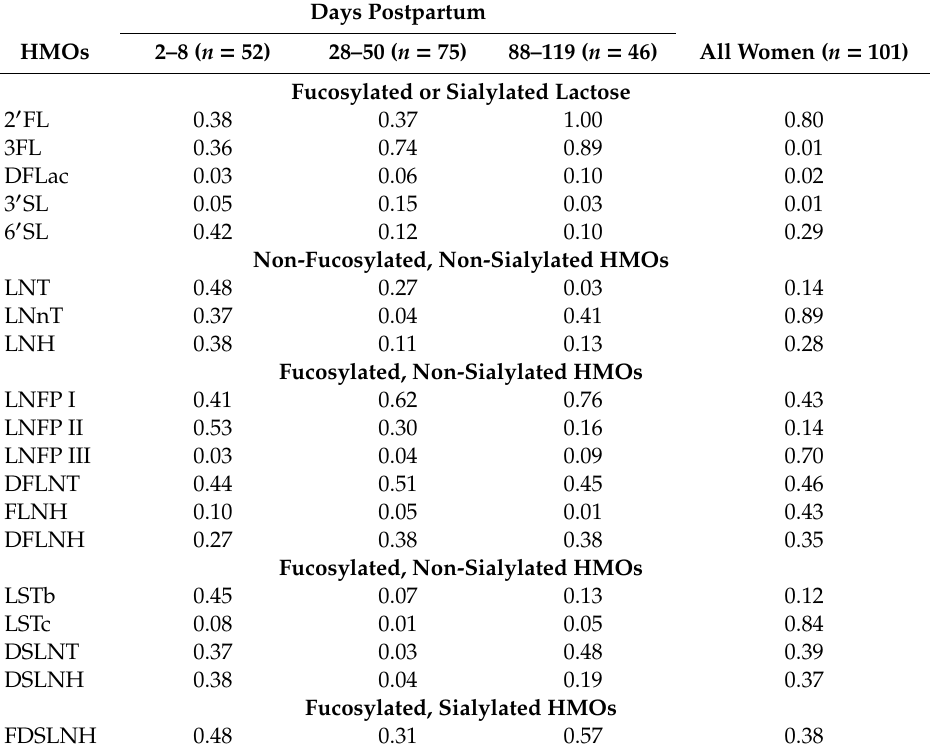
Table 5. NMF scores according to time—postpartum period and general (for all times) for individual